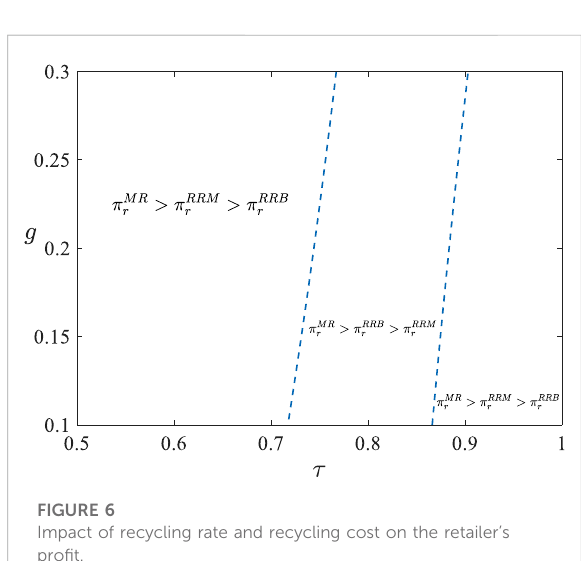
FIGURE 6 Impact of recycling rate and recycling cost on the retailer ’ s pro fi